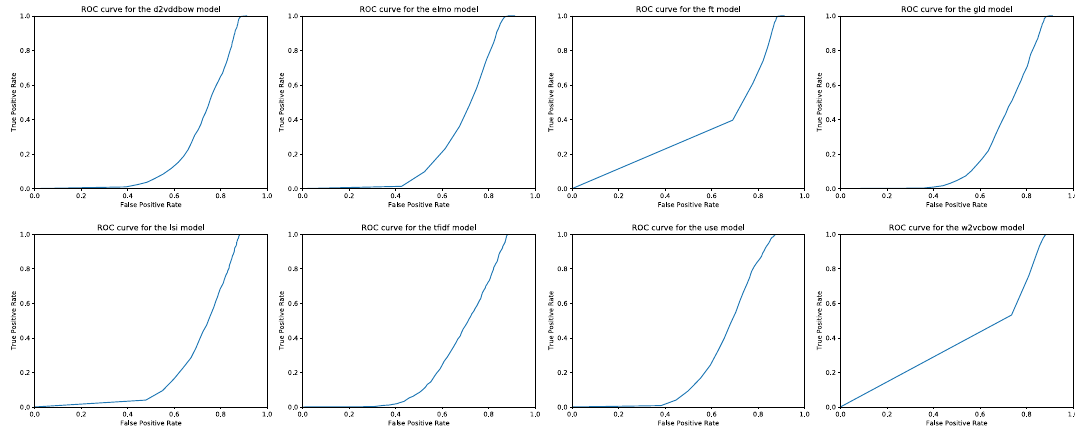
Figure A6. Receiver operator characteristic curves for eight models processing Webis corpus.